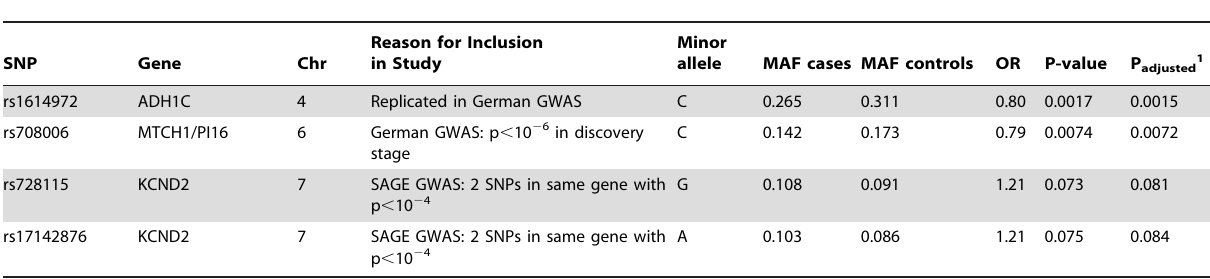
Table 1. SNPs with P , 0.1 in our Replication